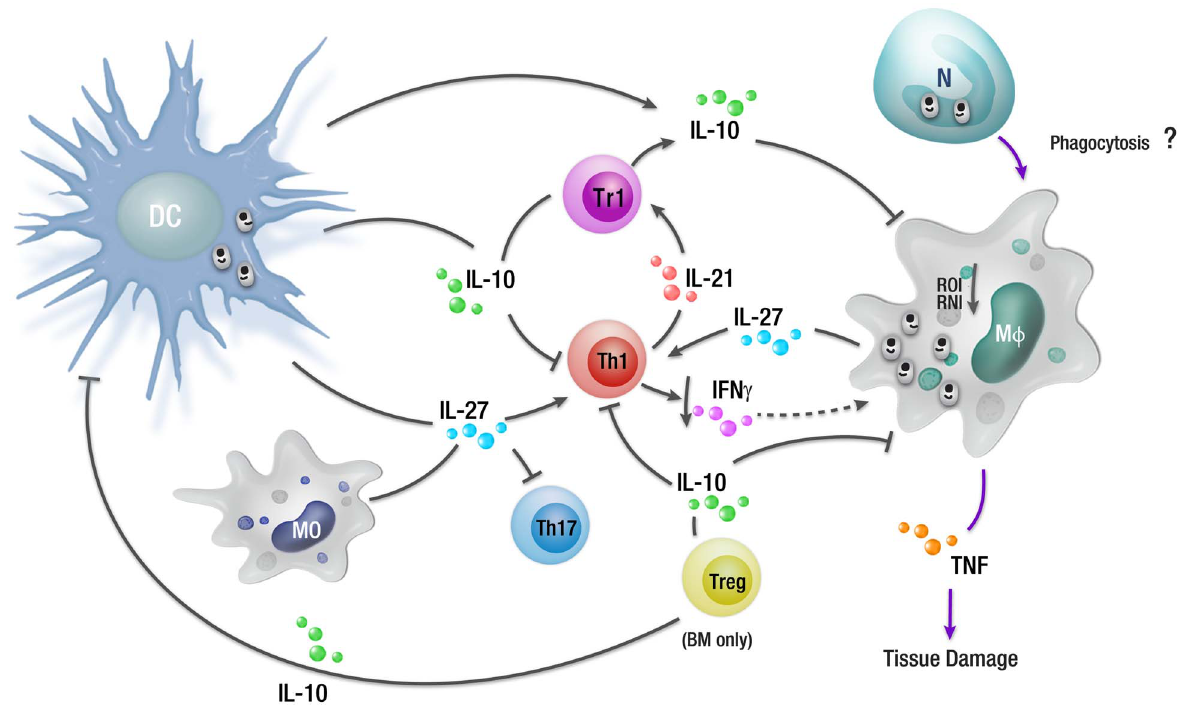
Figure 2. Overview of cellular responses during a chronic L.donovani infection. During an established L. donovani infection, a subset of regulatory DCs in the spleen can produce IL-10 that promotes the expansion of IL-10-producing regulatory T cells (Tr1), as well as inhibiting antimicrobial mechanisms in macrophages and other phagocytic cells (including suppression of ROI and RNI generation). IL-27 produced by regulatory DCs and macrophages, along with T cell–derived IL-21, can drive the differentiation of Th1 cells into Tr1 cells, as well as inhibit Th17 development. IL-10 produced by Tr1 cells can suppress antigen presentation, contributing to T cell dysfunction, as well as down-regulate CD4 + T cell IFN c production. There has been a report that IL-10 can also be produced by Treg cells in the BM of VL patients. Although uptake of infected neutrophils undergoing apoptosis by macrophages contributes to the establishment of L. major infection in mice, no such mechanism has yet been described during L. donovani infection. Abbreviations: N,